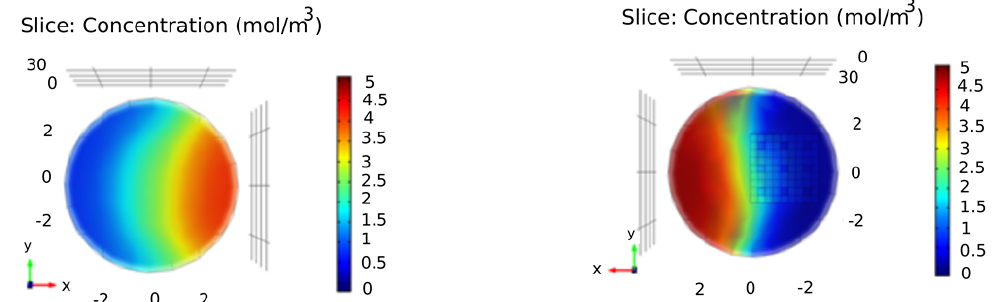
Figure 7. Sierpinski carpet object in high concentration area in the second iteration for input (front up view-right), and for output (rear up view-left), Fractal in low concentration area in the second iteration for input (front down view-right), and for output (rear down view-left).